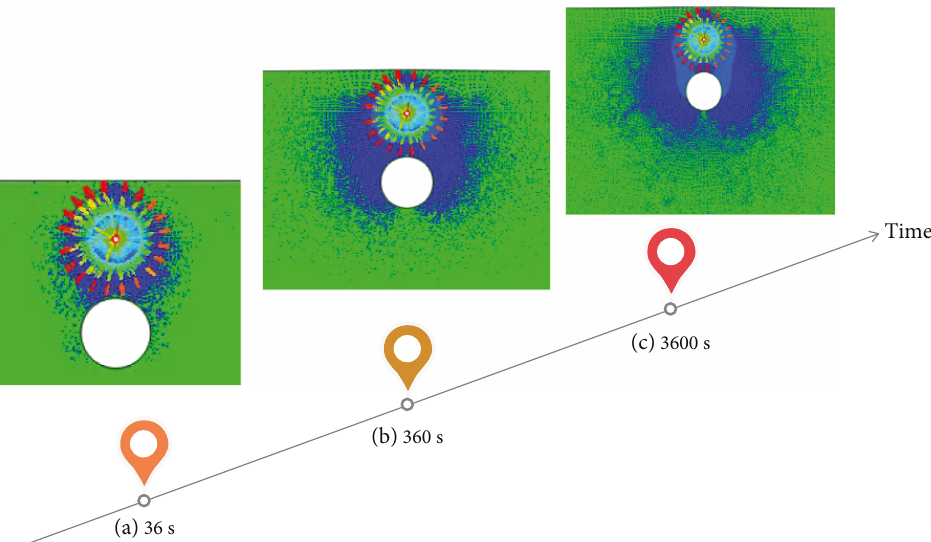
Figure 19: The path of water fl ow in a di ff erent time period of condition 1.